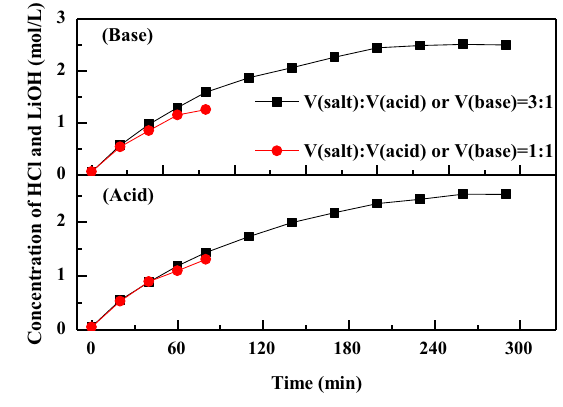
Fig. 11 Variation of HCl and LiOH concentration under different feed